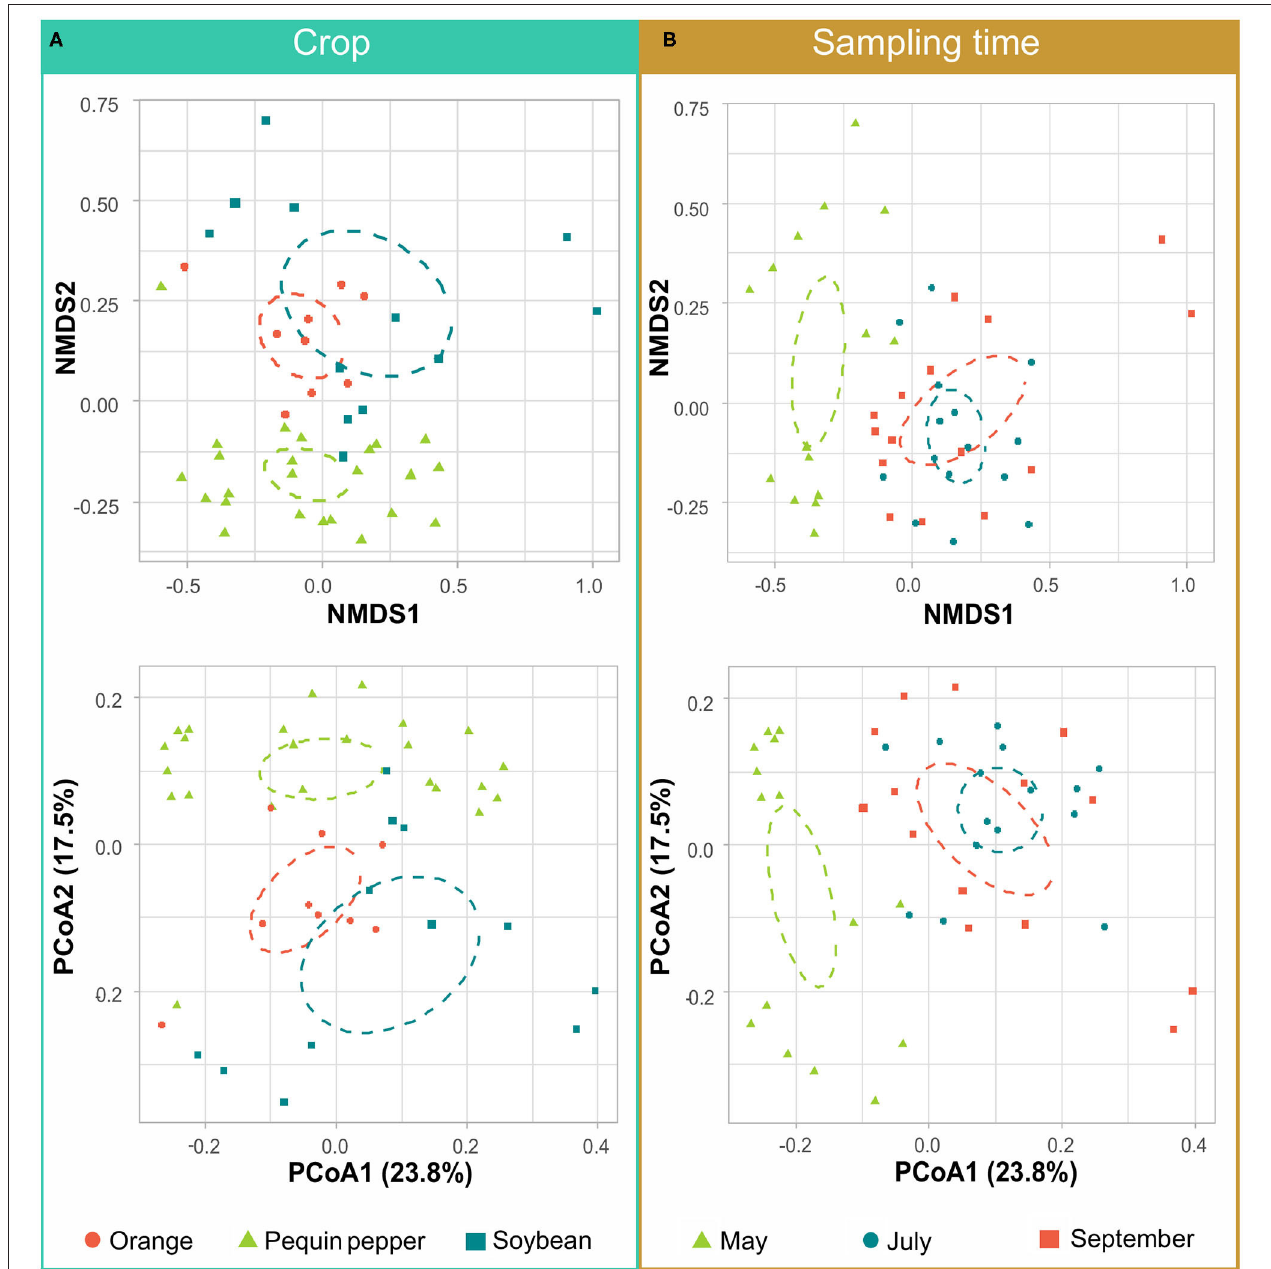
FIGURE 4 | Non-metric multidimensional scaling (NMDS) and principal coordinate analysis (PCoA) plots show differences in community composition among crops and sampling times. Samples are grouped by crop (A) and by sampling time (B) . Distribution of distinct groups is represented by 95% confidence interval ellipses. Variation explained by the data in PCoA plots is presented in